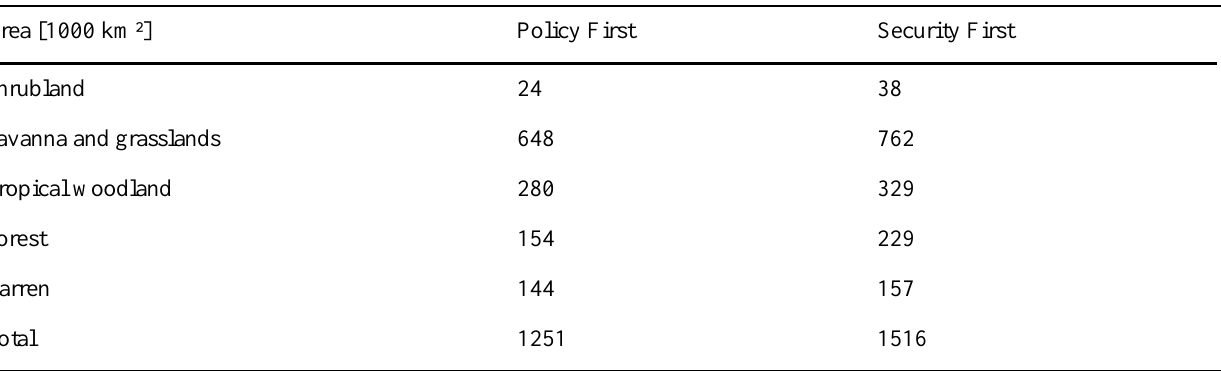
Table 3. Loss of biome area due to the expansion of cropland (biome types are derived from the GLCC land-cover data